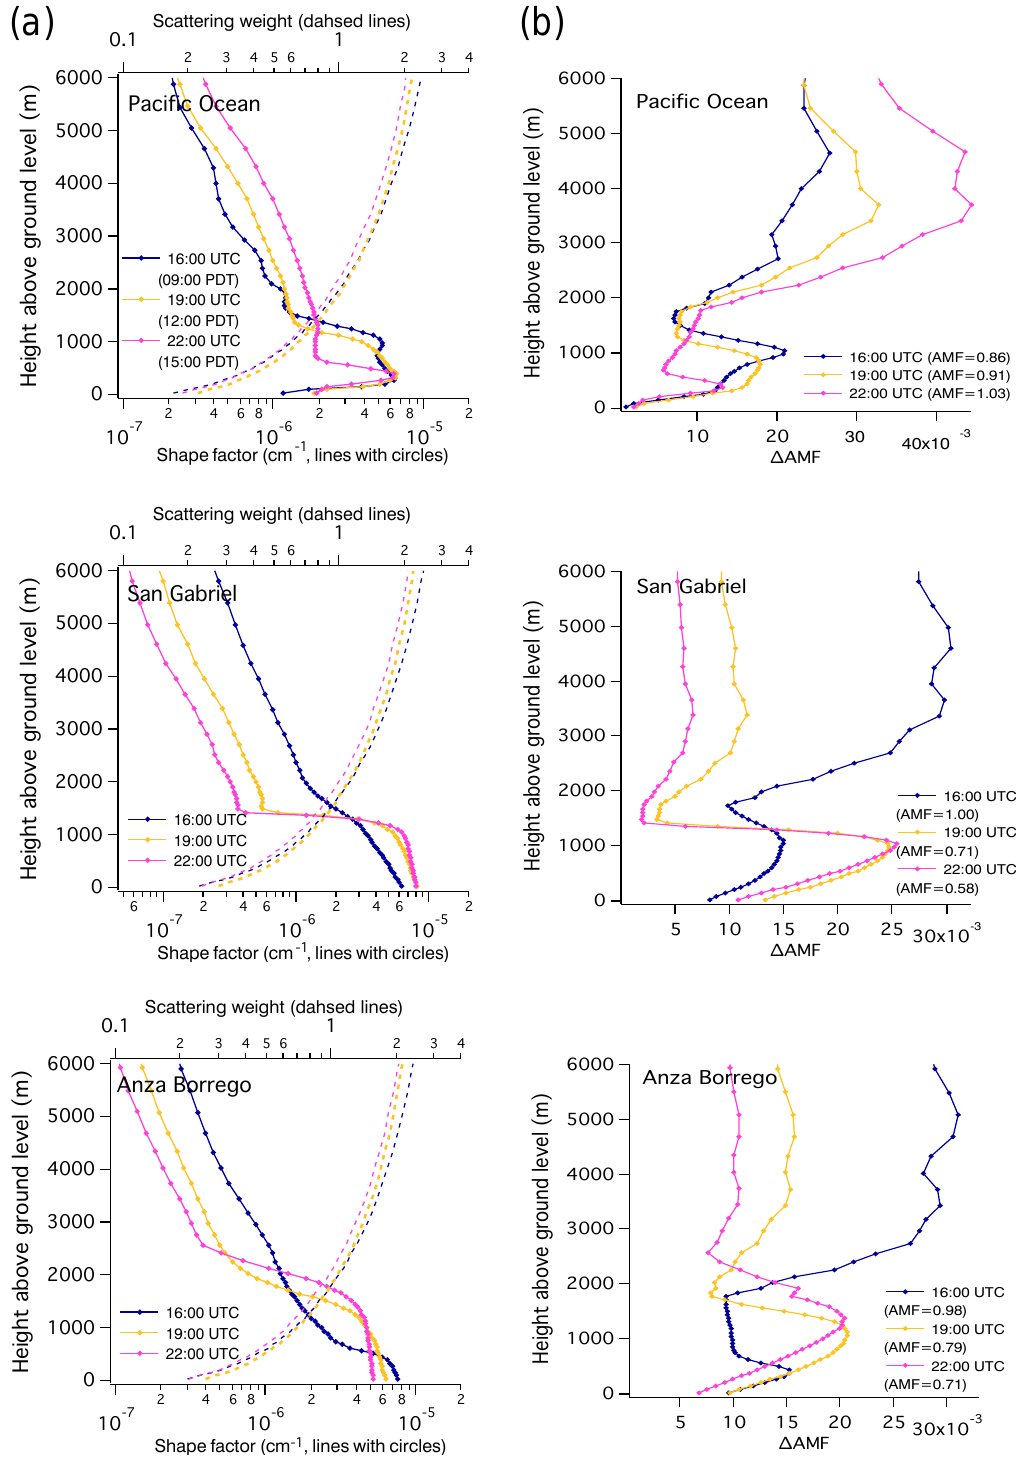
Figure 8. Vertical profiles of (a) shape factor and scattering weight and (b) (cid:49) AMF i (discrete increment of the AMF) at the North Pacific Ocean, San Gabriel Mountains, and Anza-Borrego Desert State Park. Scattering weights multiplied by the geometric AMF are shown. Dashed lines and solid lines with symbols in the left panel denote the scattering weight and shape factor, respectively. Total (or tropospheric) AMF values are shown in legends in panel (b)